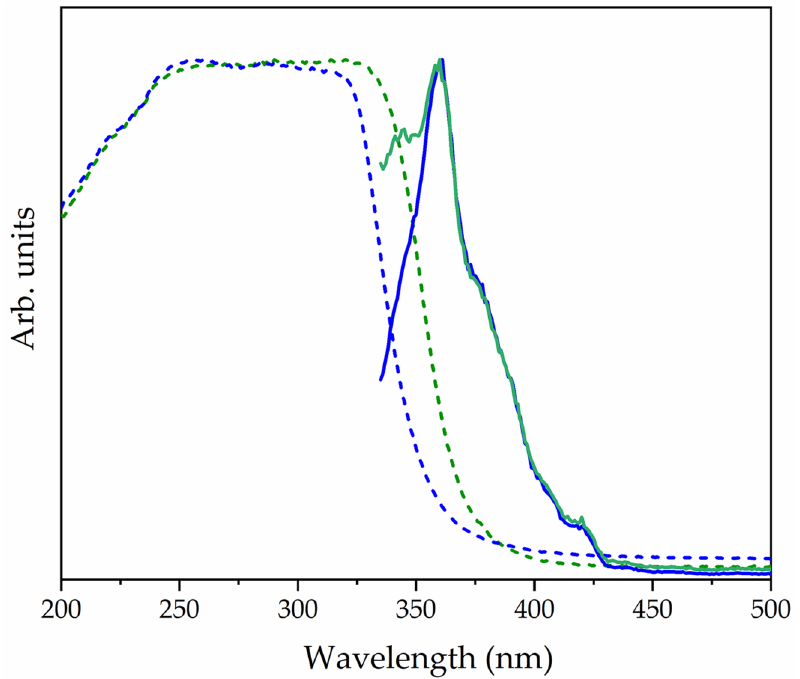
Figure 3. Normalized absorption (dashed line) and emission (solid line) spectra of compound 1 (green) and [Zn 3 ( μ -ACA) 6 (4-phpy) 2 ] (blue).